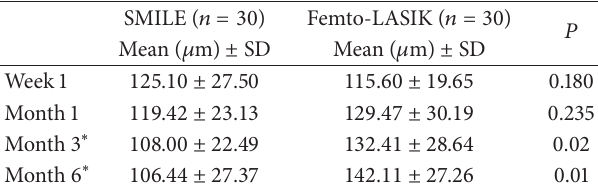
Table 6: Backscattered light intensity 150 𝜇 m below the epithelium.